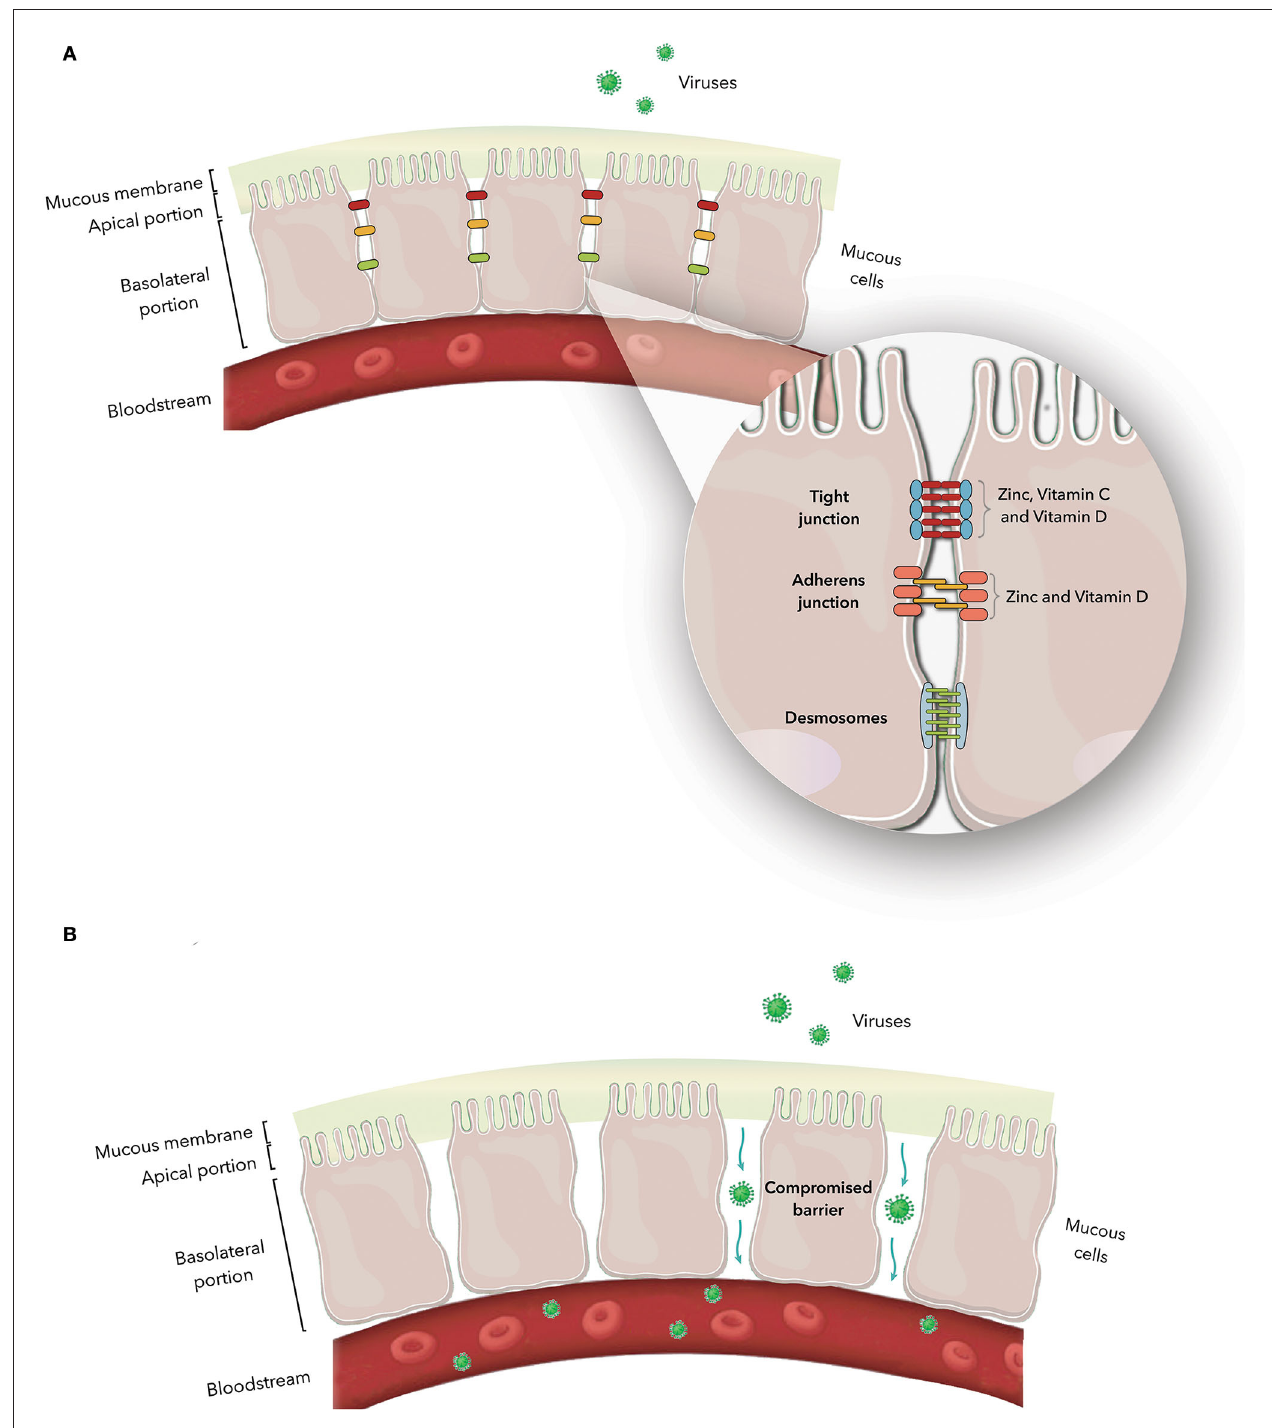
FIGURE 1 | (A) Junctional complex in epithelial cells. The magnification shows the arrangement of these structures in the paracellular space and the action of zinc and vitamins C and D on tight and adherens junction proteins. (B) Junctional complex dysfunction and its consequences. which strengthen intercellular binding. Evidence shows that these nectin-based adhesions, which are important for the initial two junctions have an interconnection, which can be either attachment between neighboring cells and for the establishment physical or through signaling of apical-basolateral polarity, and cadherin-based adhesions,